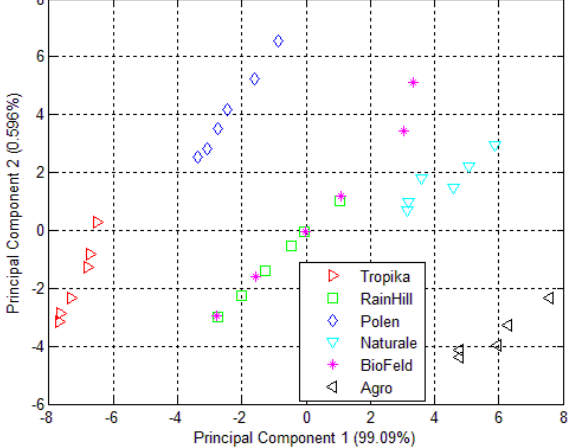
Figure 3. PCA plot of 32 e-nose sensors responses for dried Orthosiphon stamineus .